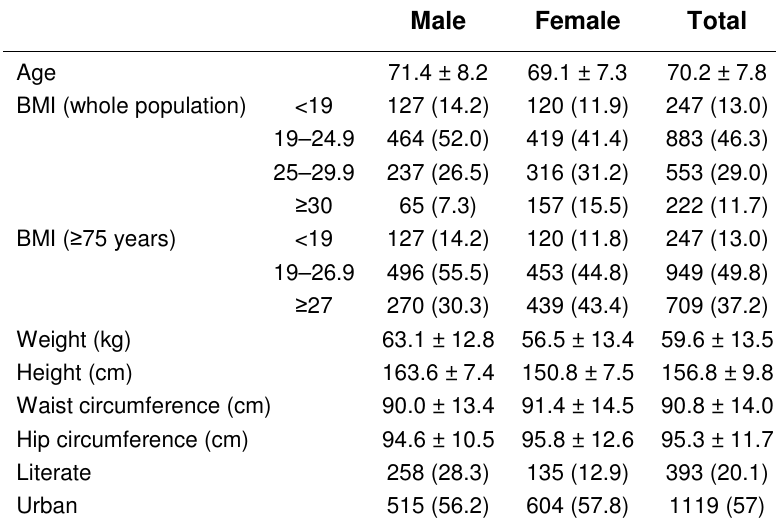
Demographic and Anthropometric Values in Elderly Population of Razavi-Khorasan Province,